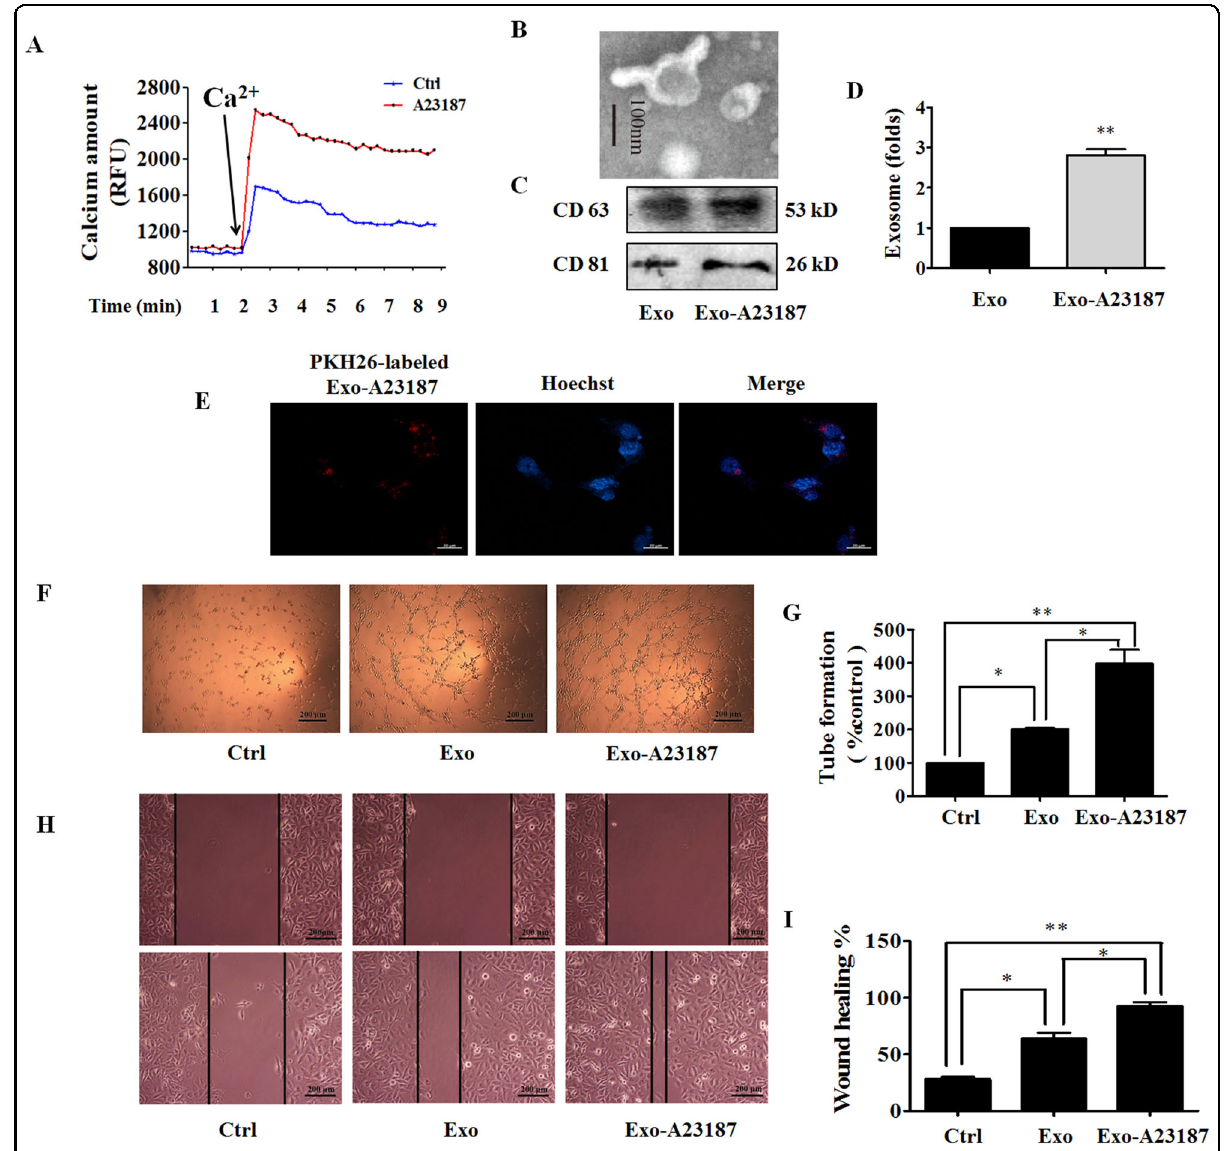
Fig. 2 Exo-A23187 promotes human umbilical vein endothelial cells (HUVEC) proliferation, tube formation, and migration. A Effect of A23187 on intracellular Ca 2 + level in MDA-MB-231 cells was determined with FluoForte Calcium Assay Kit. B Representative electron microscopic image of Exo-A23187. C The markers of exosomes in Exo or Exo-A23187 as determined by western blot. D A23187 increased the production of exosomes in MDA-MB-231 cells. E Images of intercellular traf fi cking of exosomes by isolated Exo-A23187 labeled with PKH26 in HUVECs. F Tube formation was increased in the Exo-A23187 group compared with the control and Exo group. G Quanti fi cation of the tube formation results in ( F ). H The migration of HUVECs was increased in the Exo-A23187 group compared with the control and Exo group. I Quanti fi cation of the HUVEC migration results in ( h ). Data represent mean ± SEM from three independent experiments ( n = 3). * P < 0.05, ** P <